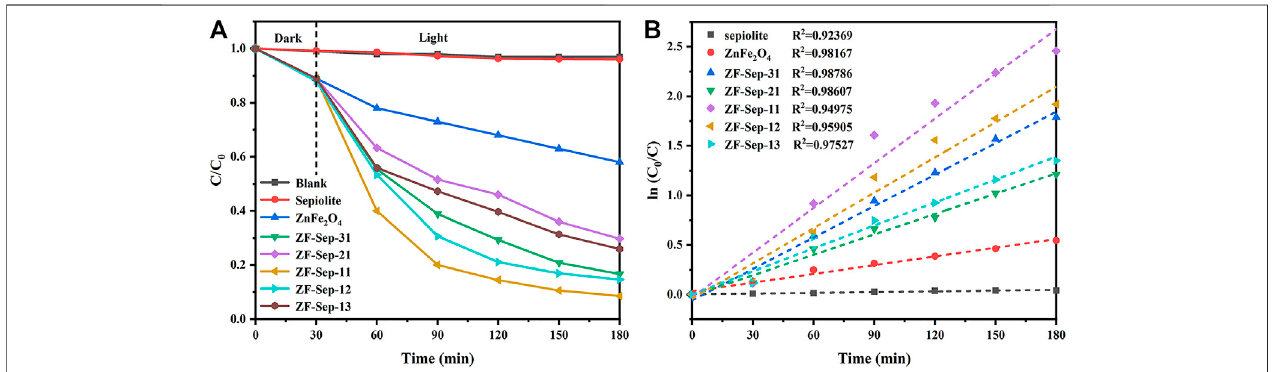
FIGURE 9 | (A) Removal of TCH under different systems, and (B) ln (C 0 /C) versus reaction time for TCH under different conditions. Reaction conditions (TCH) (cid:1) 20 mg/L (catalysts) (cid:1) 1.0 g/L (H 2 O 2 ) (cid:1) 1 mM.